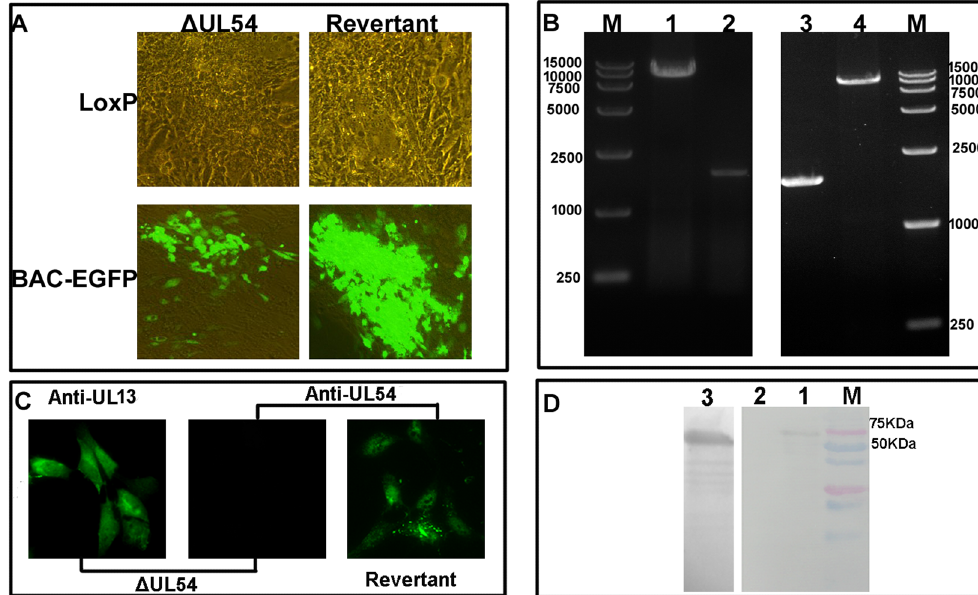
Figure 1. Construction of DEV- Δ UL54 and DEV- Δ UL54 (Revertant). ( A ) Construction of DEV- Δ UL54 and DEV- Δ UL54 (Revertant). The DEV CHv-BAC- Δ UL54 and DEV CHv-BAC- Δ UL54 (Revertant) were constructed with the Red recombinant system and rescued in DEFs cells. Using the Cre-LoxP system, the BAC-EGFP tag was removed. ( B ) Identification of DEV- Δ UL54 and DEV- Δ UL54 (Revertant) by PCR. M: DL15000; 1: DEV CHv-BAC- Δ UL54; 2: DEV- Δ UL54; 3: DEV- Δ UL54 (Revertant); 4: DEV CHv-BAC- Δ UL54 (Revertant). The target fragment size in DEV CHv-BAC- Δ UL54/DEV CHv-BAC- Δ UL54 (Revertant) was approximately 10000 bp, and it was nearly 1700 bp for DEV- Δ UL54/DEV- Δ UL54 (Revertant). ( C ) Identification of DEV- Δ UL54 and DEV- Δ UL54 (Revertant) by IFA. DEFs cells that were infected with DEV- Δ UL54 or DEV- Δ UL54 (Revertant) were subjected to IFA with Anti-UL54 polyclonal antibody as a primary antibody; DEV- Δ UL54 treated with Anti-UL13 polyclonal antibody as primary antibody was used as a control. ( D ) Identification of DEV- Δ UL54 and DEV- Δ UL54 (Revertant) by Western blot. Proteins of DEFs cells infected with DEV- Δ UL54 or DEV- Δ UL54 (Revertant) were subjected to Western blot with Anti-UL54 polyclonal antibody as a primary antibody. 1: DEV- Δ UL54 (Revertant); 2: DEV- Δ UL54; 3: DEV- Δ UL54 subjected with Anti-UL13 polyclonal antibody as a primary